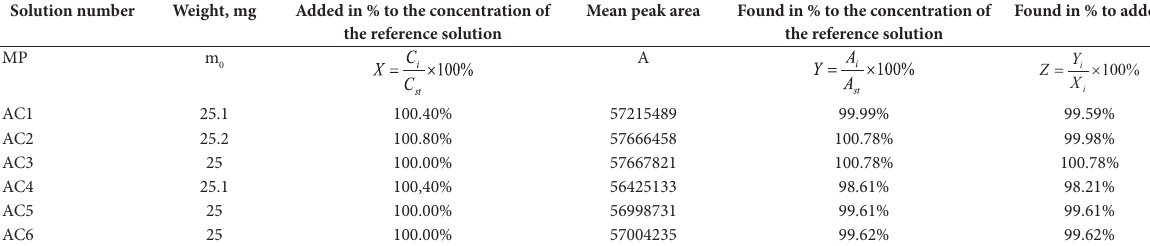
Table 8. Intra-laboratory precision (second analyst).